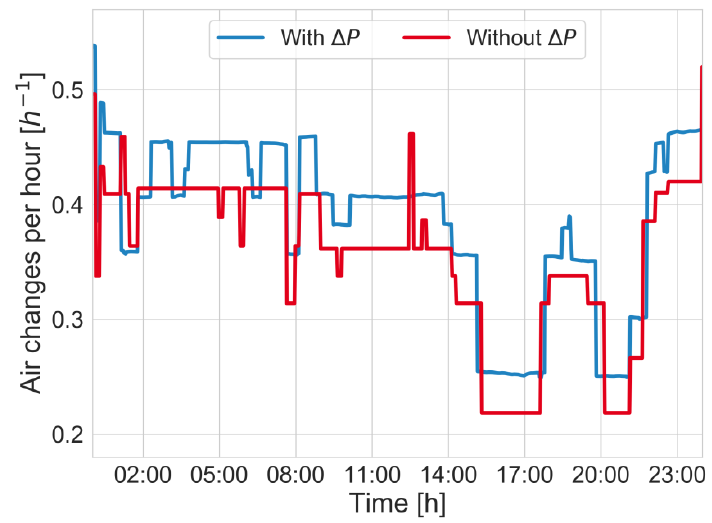
Figure 19. Total air exchange rate considerin g (with ΔP) and neglecting (without ΔP) pressure between the rooms and the façade in a single difference between the rooms and the façade in a single day.